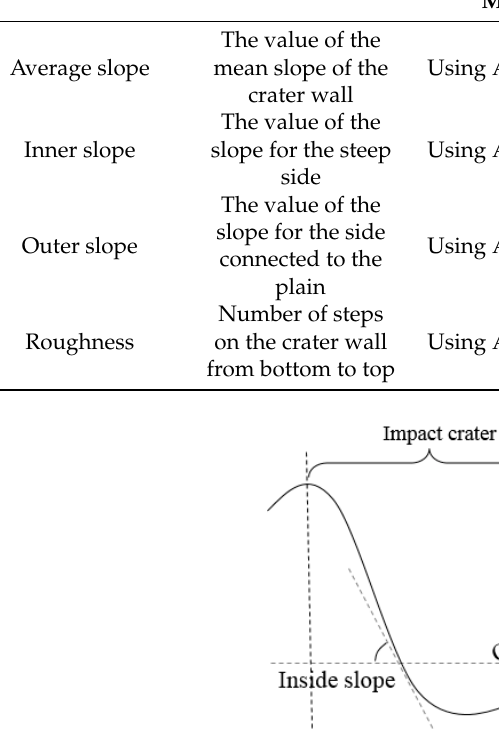
Figure 7. Schematic description for some of the indices in Table 3.